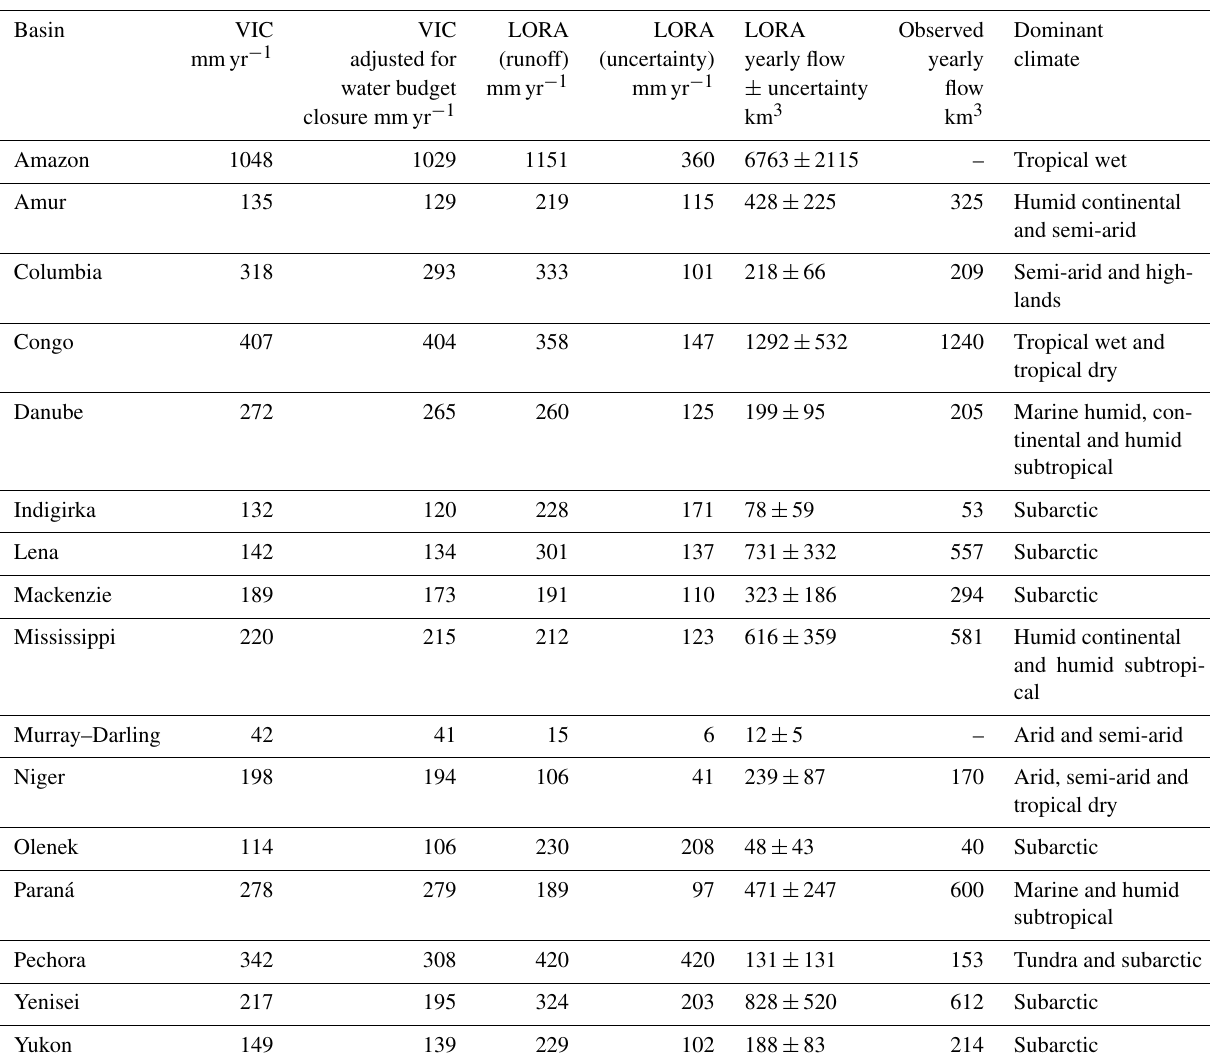
Table 2. A comparison of mean annual runoff (mmyr − 1 ) of 16 major basins covering different climate zones around the world for LORA and VIC (Zhang et al., 2018), the yearly volume of LORA runoff aggregates (i.e. flow in km 3 ), and observed annual flow (km 3 ) over the basins and mean annual uncertainty values associated with LORA runoff are shown, and the adjusted VIC annual runoff values within 5% error bounds for water budget closure are displayed. Observed annual flow is given only if data from all contributing stations are available over a whole year over for at least 17 years out of the 33 years covered in this